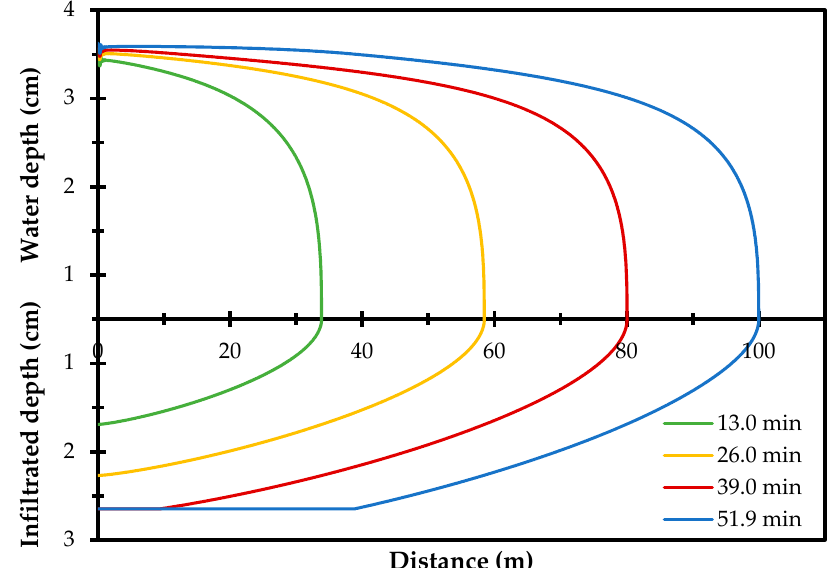
Figure 7. Flow profiles every 13 min of a border irrigation with a shallow water table.